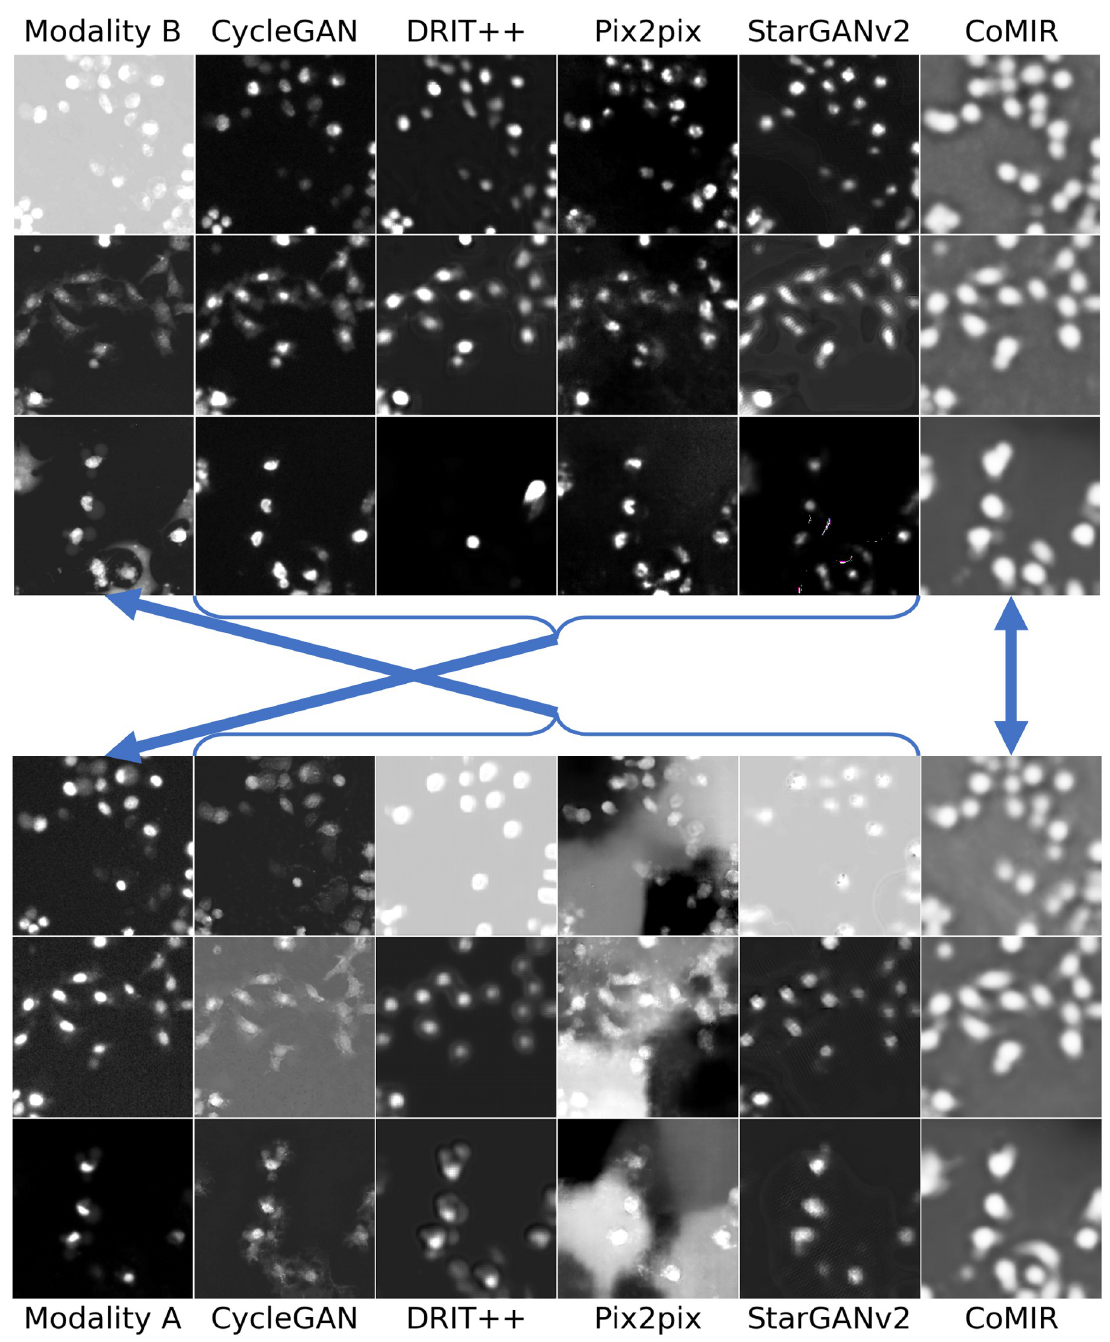
Fig 5. Modality-translated image samples of the Cytological dataset by different evaluated methods (contrast-enhanced for visualisation). Each row shows the results on one random image from each fold. Images in Columns 2–6 are generated from the images in (the corresponding row of) Column 1. Top block: Translations generated from Modality B. Bottom block: Translations generated from Modality A. The arrows indicate what to compare for visual inspection of the level of achieved similarity (pointing from generated images to the corresponding target of the learning